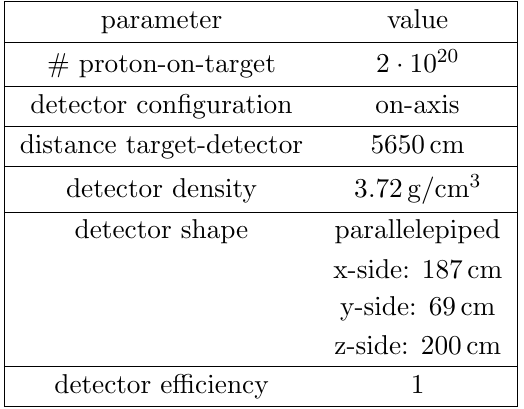
Table 1. Main input values used for the simulation of the SHiP detector geometry, as reported in ref.